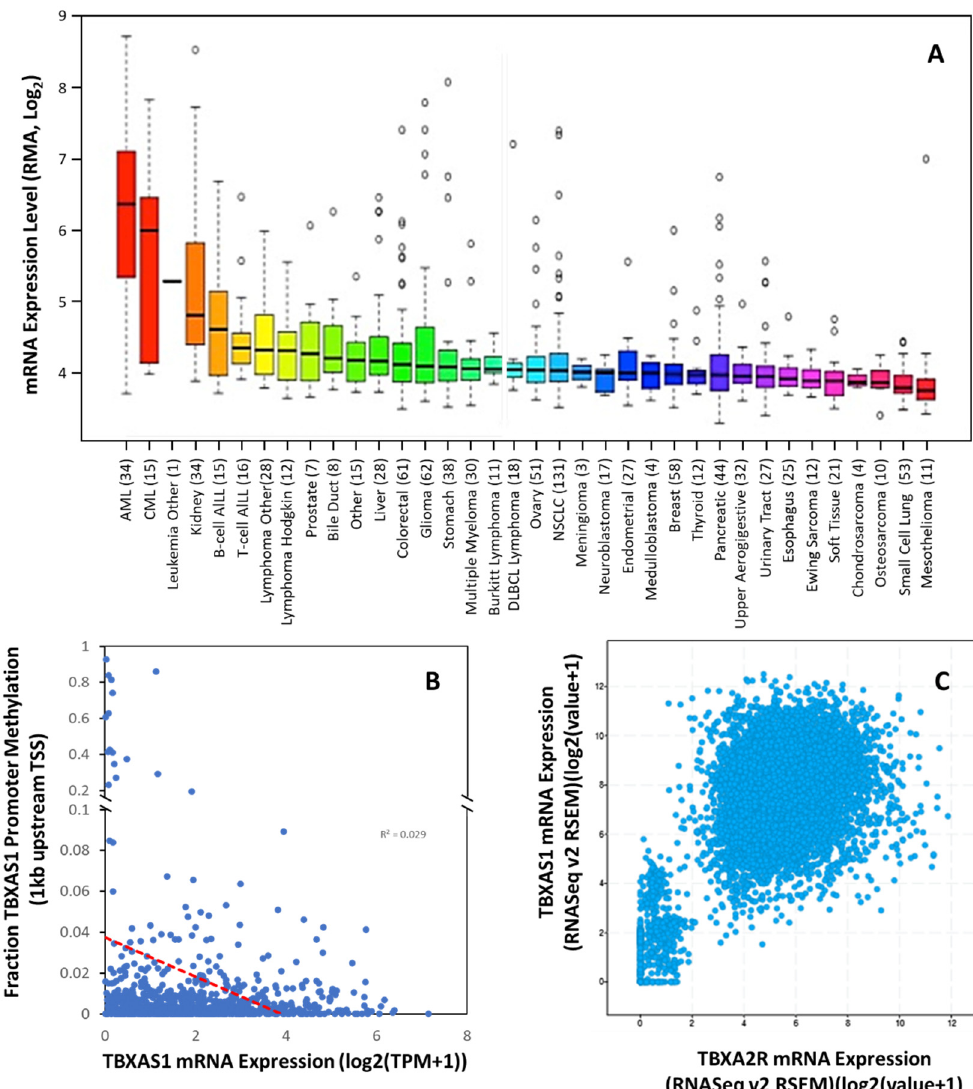
Figure 4. TBXAS1 Expression is Dysregulated in Multiple Tumors. ( A ) Expression of TBXAS1 mRNA in 36 different cancer cell types. Data are mean ±SD showing 95% CI. Numbers above descriptors on the X -axis denote the number of individual cell lines from which the data were derived. ( B ) TCGA data from 59,132 patient samples showing the correlation between TBXAS1 mRNA expression and methylation of the promoter (within 1 kb of transcriptional start site (TSS)). Red dotted line denotes linear correlation (R 2 = 0.029). ( C ) Correlation of TBXA2R and TBXAS1 expression for cancers in the TCGA pan cancer dataset.